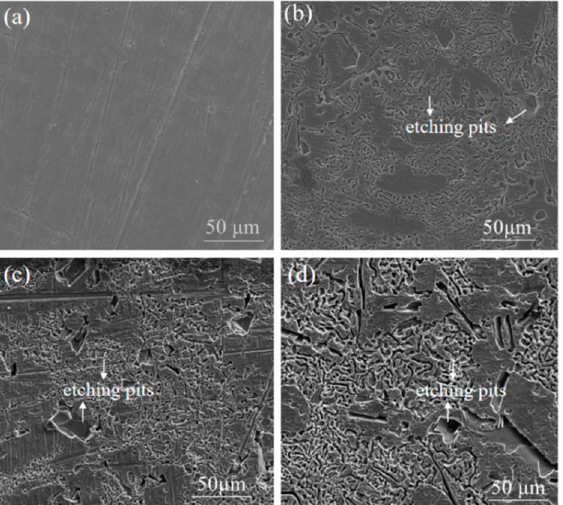
Figure 2. Surface topography of Al-12 Si after ( a – d ) 0, 15, 30, and 60 s etching treatment.